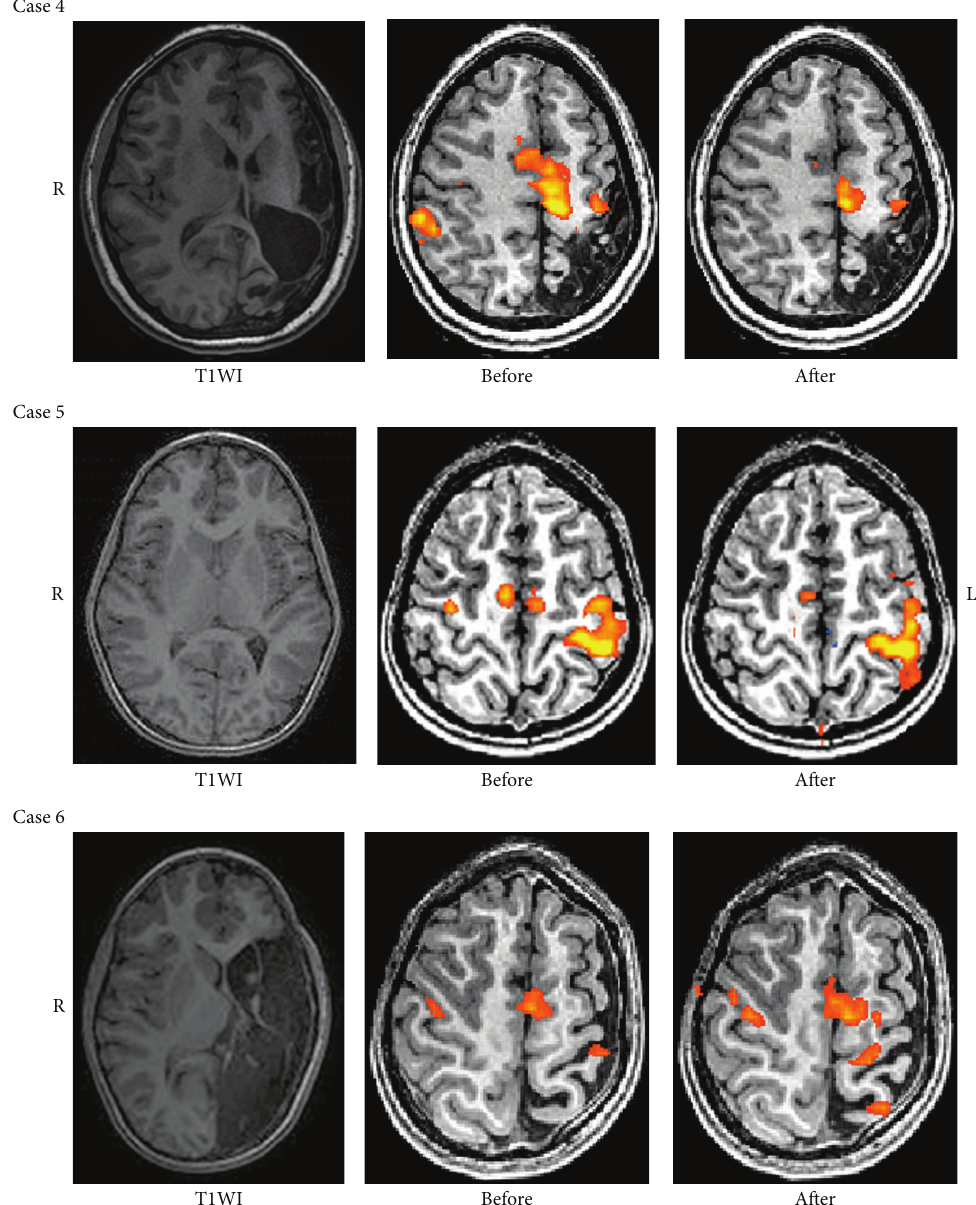
Figure 3: Examples of fMRI motor activation in areas around the central sulcus and supplementary motor area (SMA) for the condition of moving the affected hand. T1WI = T1 weighted imaging. In cases 4 and 5, a more unilateral pattern of activation is seen after intervention. In case 6, there is more activation in the affected hemisphere after